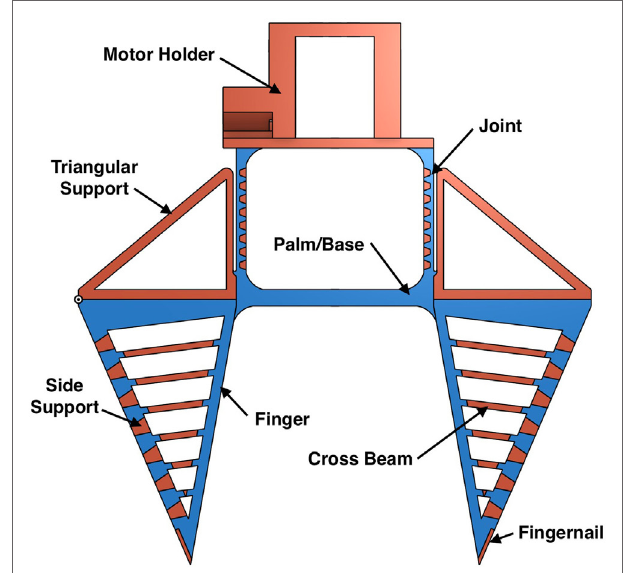
and soft material are represented by red and blue, respectively.